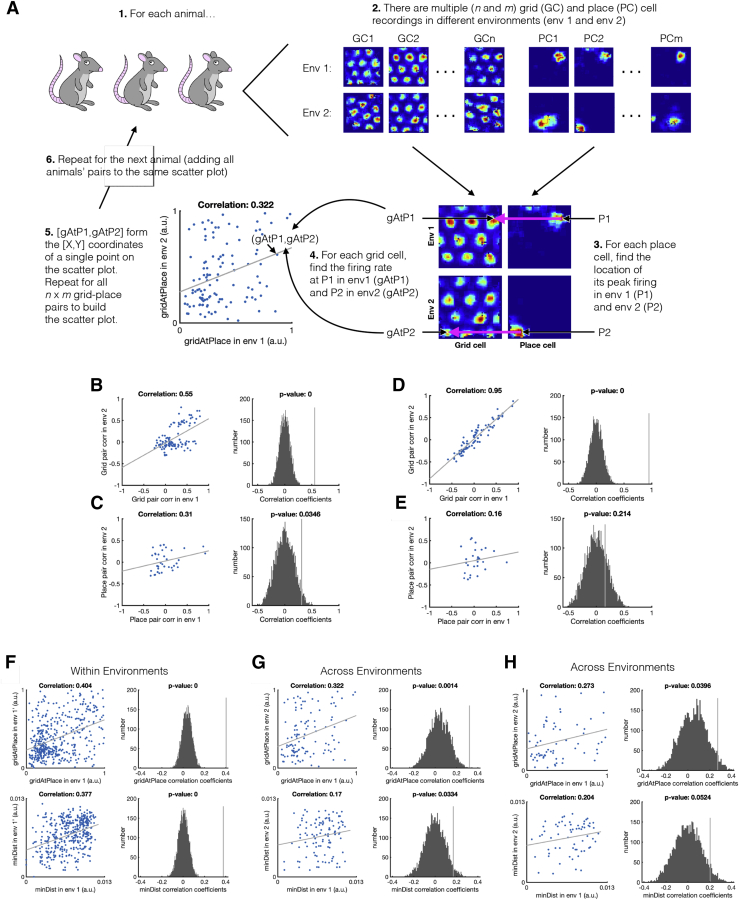
Schematic of Analysis Showing Preserved Grid-Place Relationships after Remapping, with Corresponding Results, Related to Figure 6A) Schematic explaining the gridAtPlace analysis. Specifically how the scatterplot is generated. Note that in this figure original grid cell rate maps are shown, rather than ideal grid cell rate maps (Figures S6A–S6C) that were used to generate the main text figures. B-C) The grid cell correlation structure is preserved across environments in dataset 1. B) Dataset 1. Scatterplot shows the correlation across environments of the spatial correlations of grid cell-grid cell pairs (i.e., the correlation of the upper triangle of two grid cell by grid cell correlation matrices: one from environment 1 and one from environment 2). The histogram shows this correlation coefficient was significant relative to a null distribution of correlation coefficients obtained by permuting grid cell-grid cell pairs. (C) Same as A for place cells. D-E) Replication of preserved grid cell correlation structure across environments in dataset 2. D and E are the same format as (B) and (C). F-G) Preserved relationship between place and grid cells across environments in dataset 1. The scatterplots show the correlation of a given measure across trials, where each point is a place cell-grid cell pair. The histogram plots show where this correlation (gray line) lies relative to the null distribution of correlation coefficients. The p value is the proportion of the null distribution that is greater than the unshuffled correlation. (F) gridAtPlace (top) and minDist (bottom) measures are strongly significantly correlated over two trials within the same environment, as expected given the same place and grid code should be present. (G) These measures are also significantly correlated across the two different environments, providing evidence that place and grid cells retain their relationship across environments. (H) Replication of the preserved relationship between place and grid cells across environments in dataset 2. The gridAtPlace measure is significantly correlated at p<0.05 across real and virtual worlds and the minDist measure is trending very close to significance, replicating the preserved relationship between grid and place cells across environments.